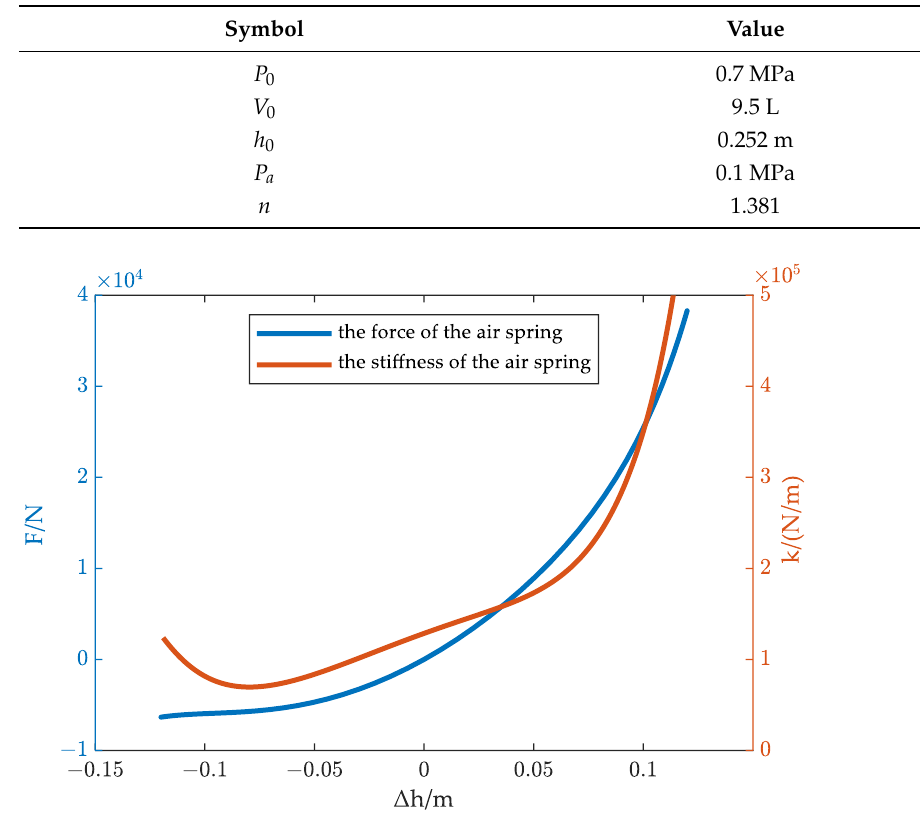
Figure 4. The mechanical behavior of air spring.